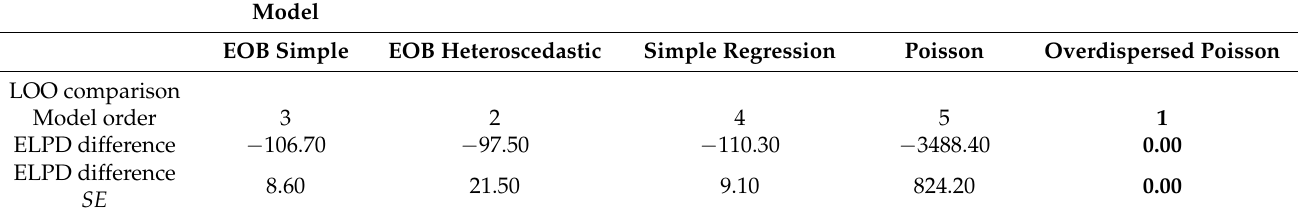
Table notes. LOO = leave-one-out cross-validation. ELPD = expected log-pointwise predictive density. SE = stan- dard error.